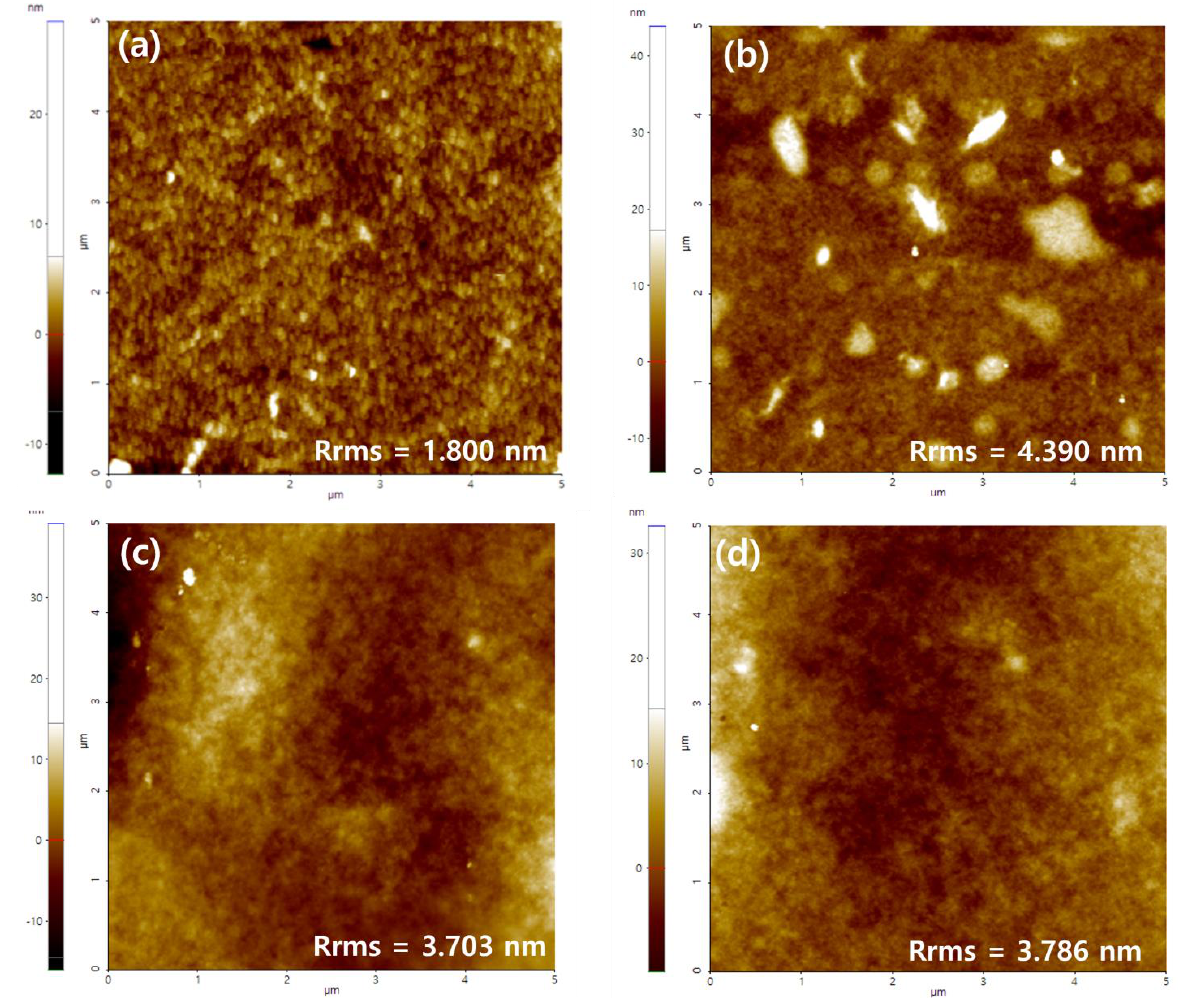
Figure 3. AFM surface images of ( a ) PEDOT:PSS, ( b ) PEDOT:PSS-HT, ( c ) TA-PEDOT:PSS, and ( d ) TA-PEDOT:PSS-HT films.